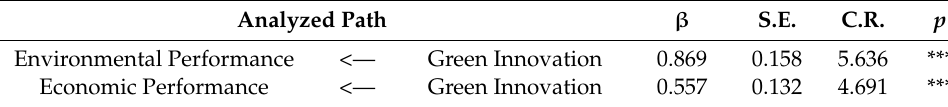
Table 6. Model regression weights. Analyzed